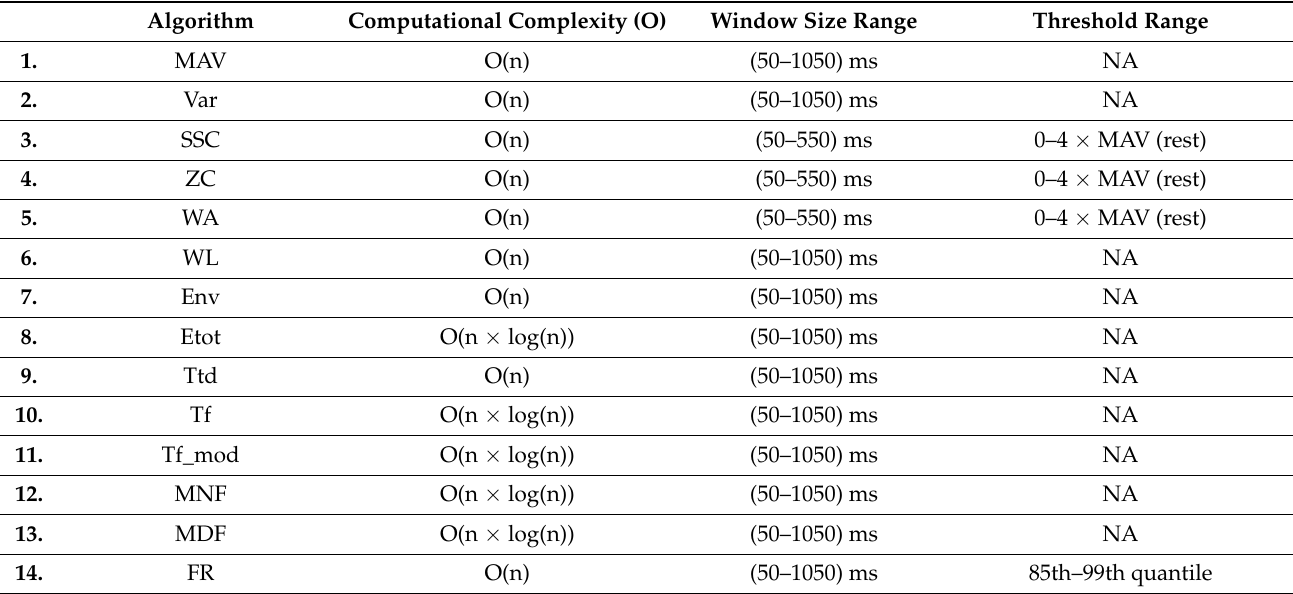
Table 2. Parameters and the ranges in which they were varied for different